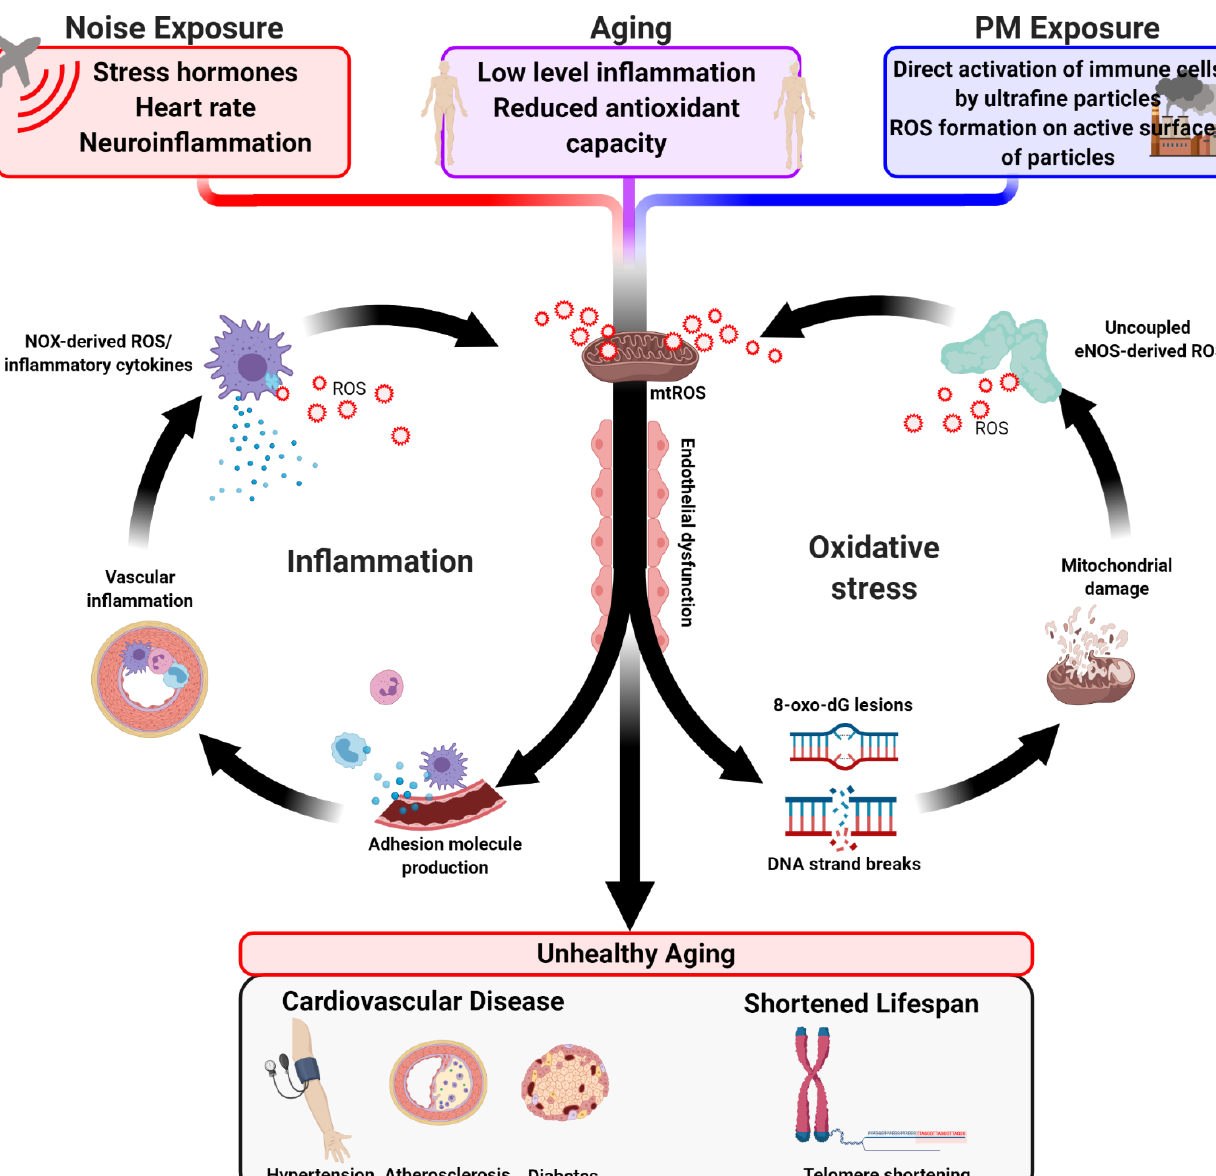
Figure 4. Convergence of pathomechanisms underlying the aging process as well as the environmental stressor traffic noise exposure and air pollution, leading to an increased risk of CVD and neurological disease. Blue dots indicate released adverse signaling cytokines and red circles the release of detrimental ROS. Created with BioRender.com.